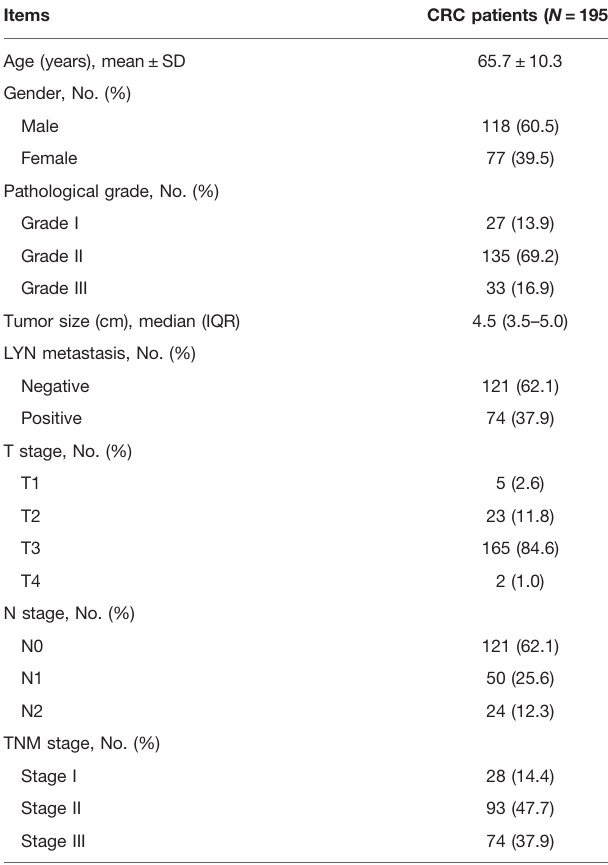
TABLE 1 | Clinical characteristics of CRC